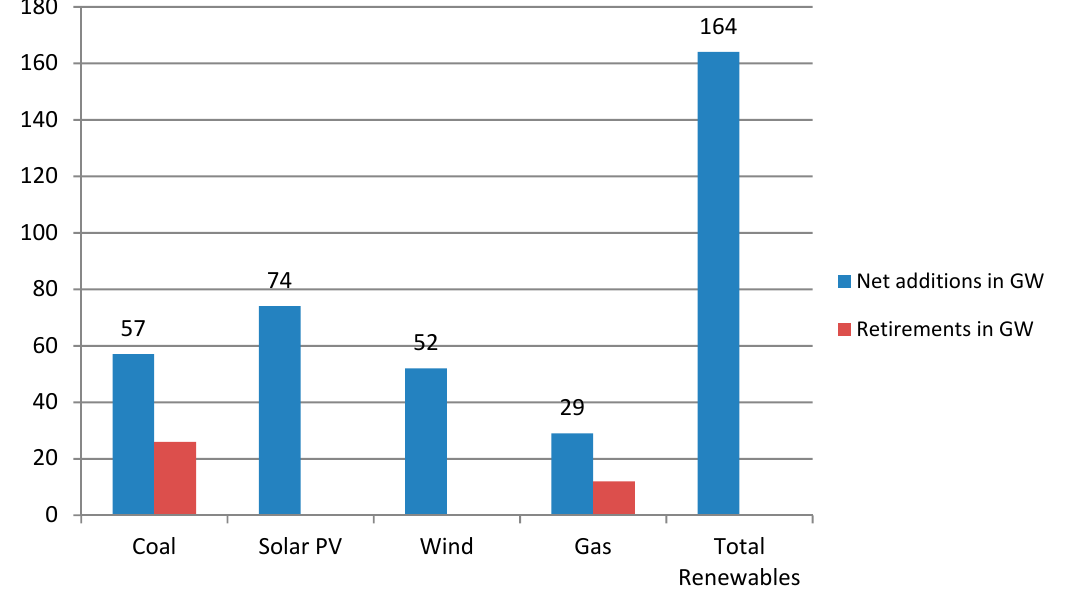
Figure 1. Net additions and retirements of Electricity capacity in 2016. Reproduced from [1], International Energy Agency: 2017 .